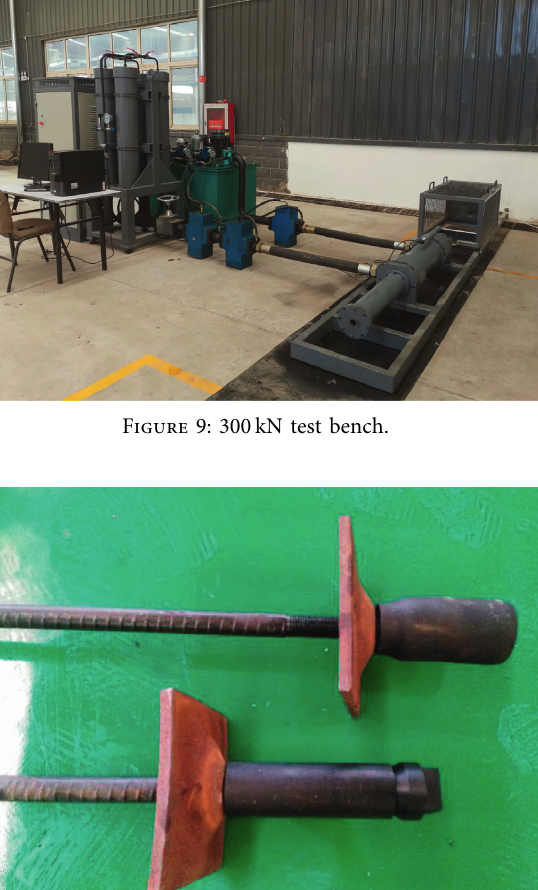
Figure 10: Before and after experiment contrast.